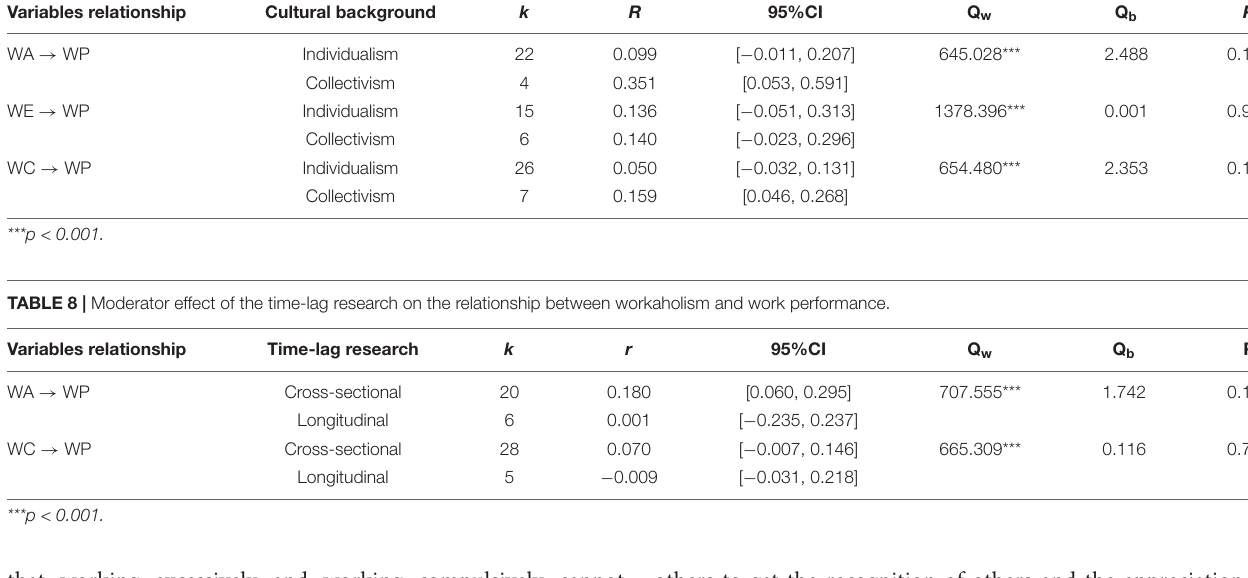
TABLE 7 | Moderator effect of cultural background on the relationship between workaholism and work performance. Variables relationship